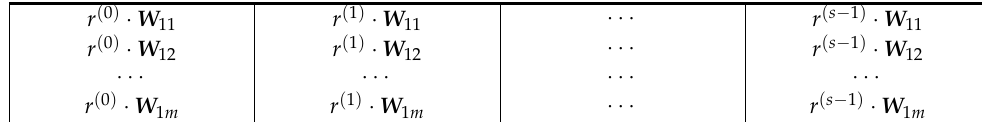
Table 2. Pre-computation table locally maintained by IoT